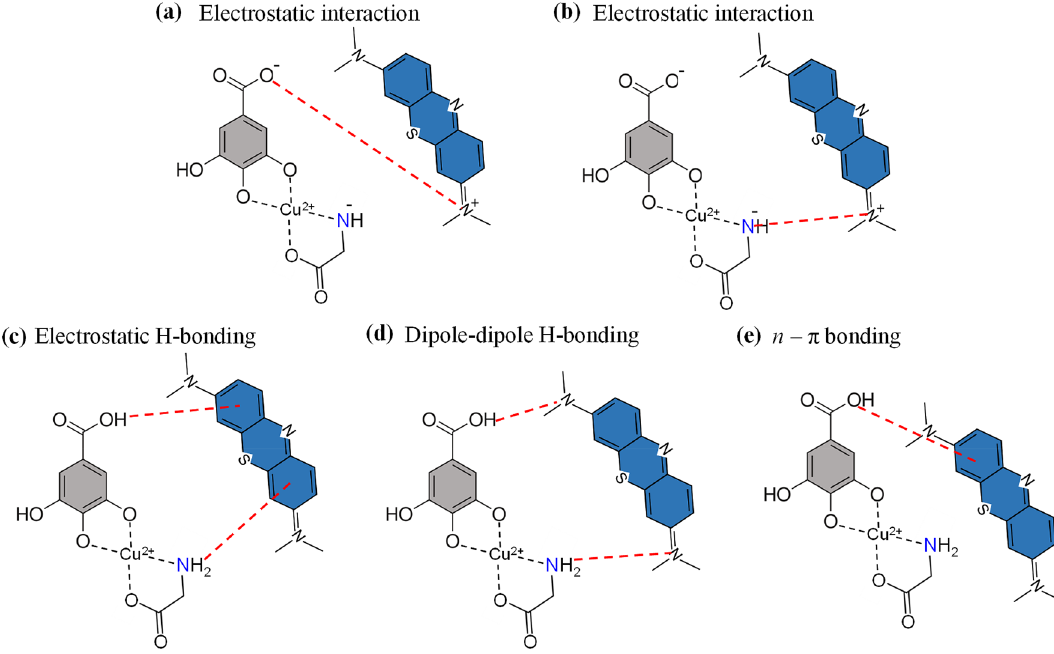
Figure 4. Possible interactions that induce adsorption of MB by N g